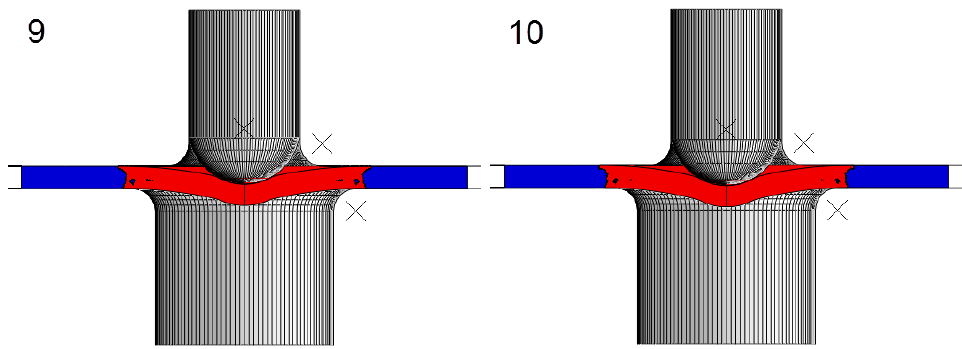
Figure 7. Elastic (blue) and plastic (red) zones in the SPT specimen at positions 9 to 10.